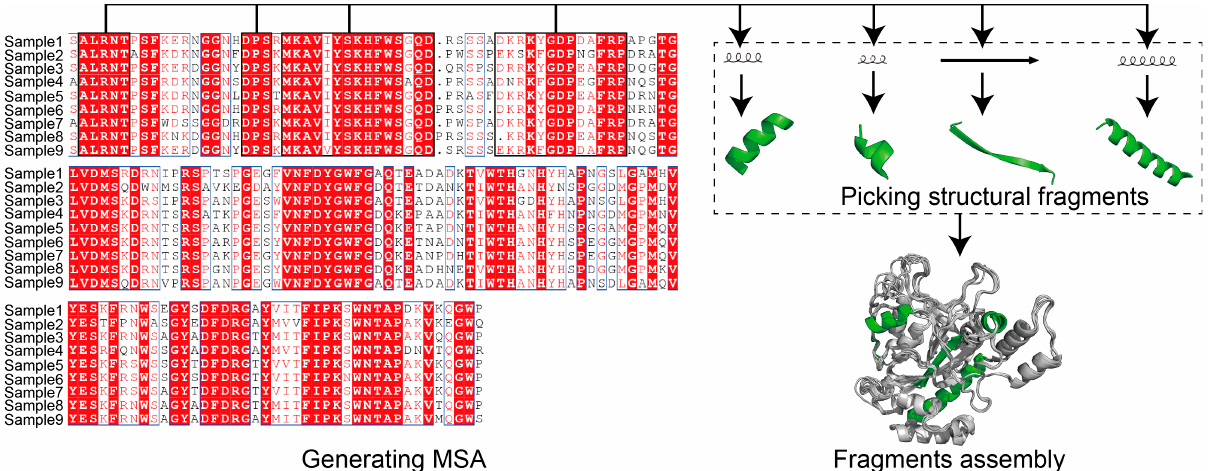
Figure 2. Using MSA for structural modeling. Multiple sequences alignment (MSA) describes aligning protein sequences to highlight the conserved region. For protein modeling, MSA information is used to guide searching of structural fragment templates prior to whole structure folding. Protein sequence alignment was generated using Jalview (Andrew Waterhouse and Geoff Barton's group, Dundee, Scotland). Protein structure generated using PyMol (Schrödinger, New York, NY, USA).